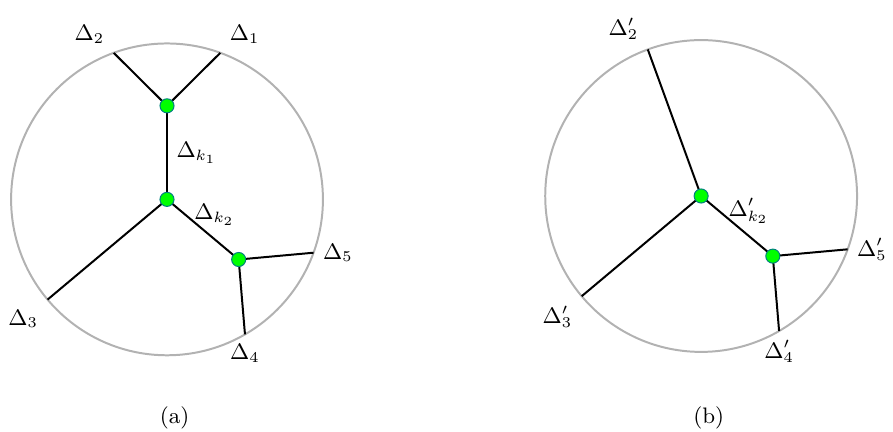
Figure 24 . (a) A canonical 5 -point AdS diagram, and (b) the associated 4 -point diagram.